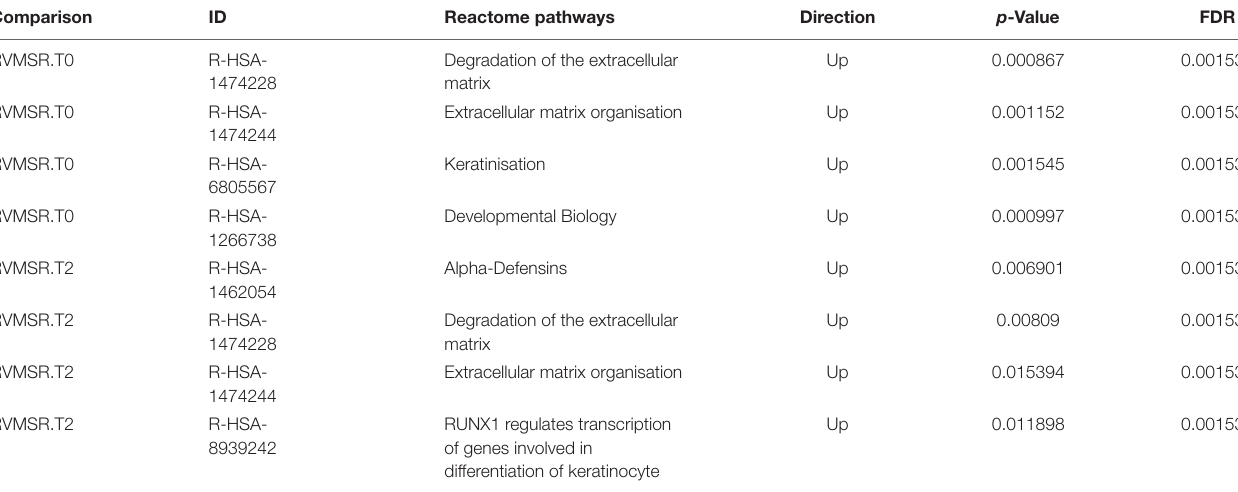
TABLE 6 | Validated differentially regulated Reactome pathways in R and MSR groups throughout the trial.